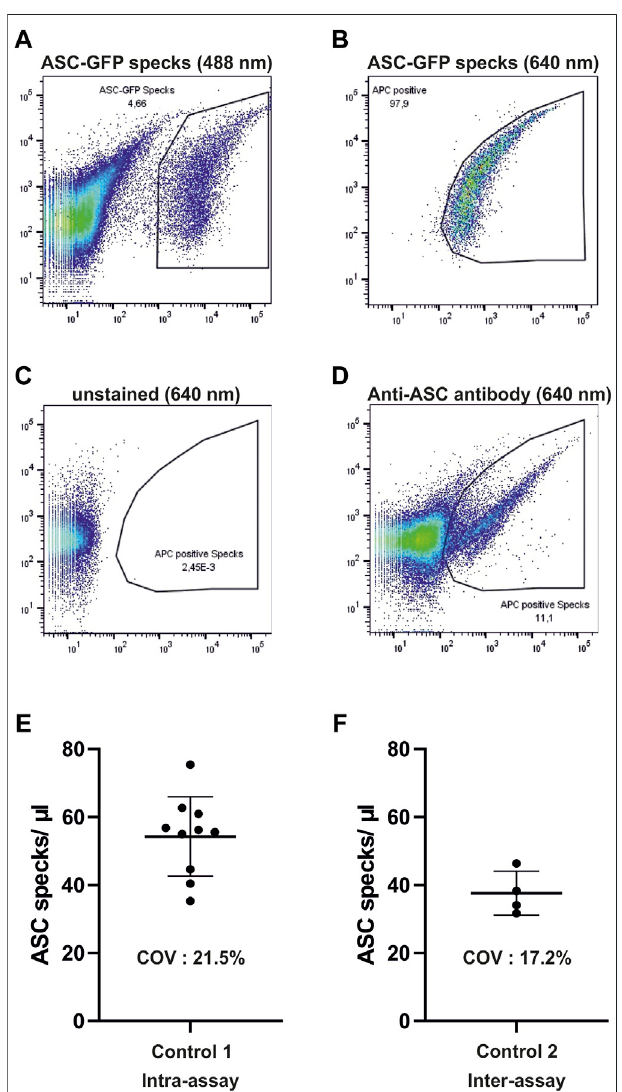
FIGURE 1 | Gating strategy and validation of fl ow cytometric measurements of ASC specks. (A,B) Depicted are dot plots of isolated ASC- GFP particles which are labeled with ASC-B3-Alexa-647 antibodies in human serum in the 488 and 640-nm channels. (C,D) Resulting gate in the Alexa-647 channel is then used for the detection of ASC-specks in human serum after staining with AS-B3-Alexa-647 antibodies. (E,F) One control subject without prior exercise was measured ten times (intra-assay) and another one on four different days (inter-assay) to test for accuracy of measurements. COV, coef fi cient of